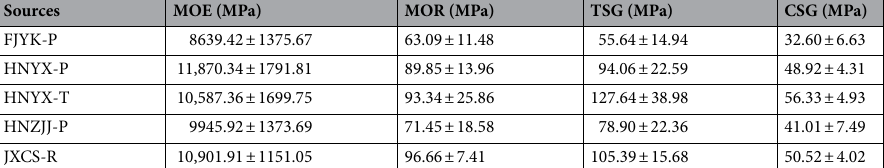
Table 3. The statistical analysis of wood mechanical properties of Chinese fir. Data are means ± SE. MOE modulus of elasticity (MPa), MOR modulus of rupture (MPa), TSG tensile strength parallel to grain (MPa), CSG compression strength parallel to the grain (MPa).